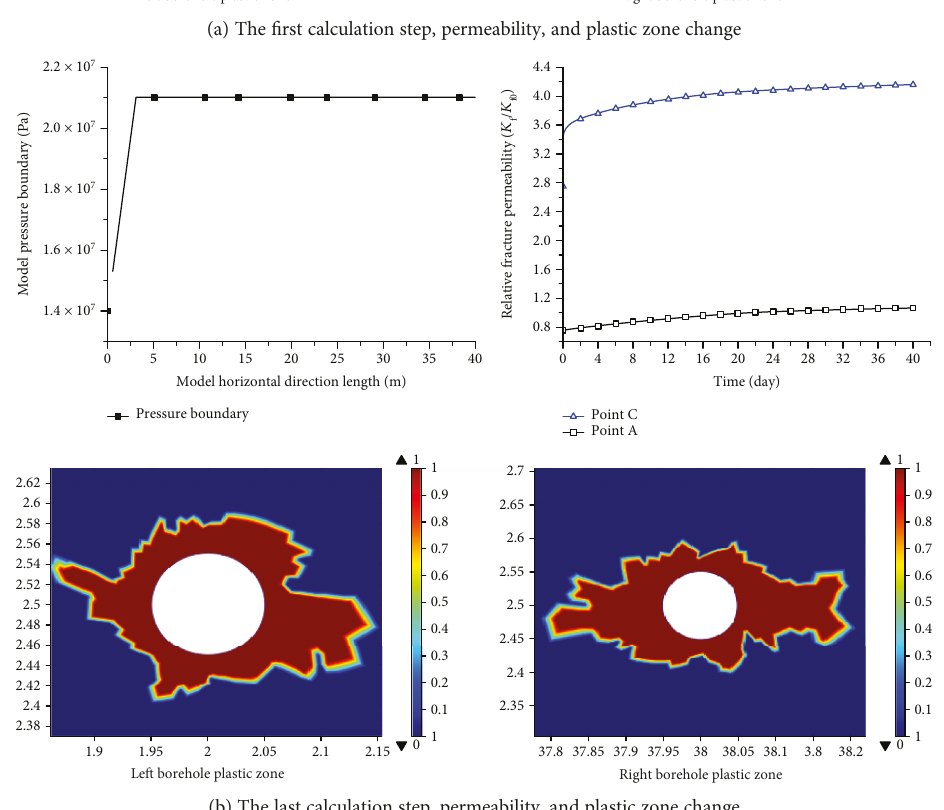
Figure 6: Di ff erent calculation steps, permeability, and plastic zone